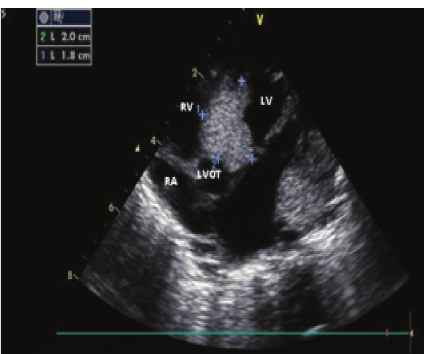
Figure 1: Echocardiography showing a great mass in the LVOT region of the heart (postnatal in the first day).